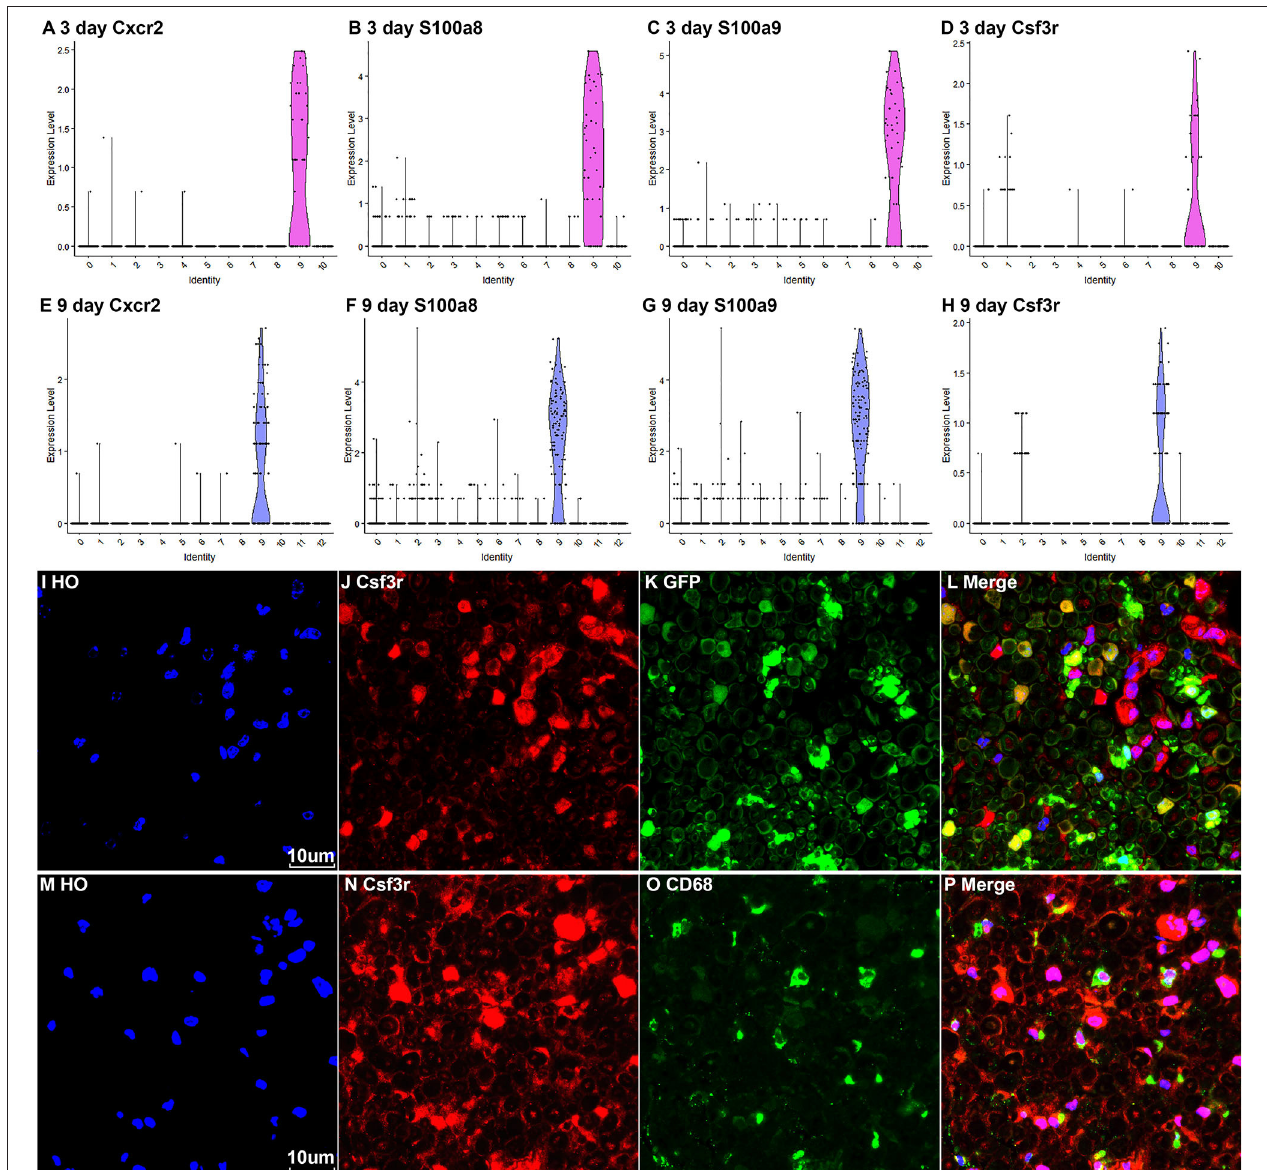
FIGURE 8 | Marker genes for identifying the cluster of neutrophils in injured nerves. (A–D) Violin plot of selected marker genes Cxcr2, S100a8, S100a9, and Csf3r for neutrophils at day 3 post-injury. (E–H) Violin plot of selected marker genes Cxcr2, S100a8, S100a9, and Csf3r for neutrophils at day 9 post-injury. (I–L) Csf3r staining showing neutrophils in the distal nerve of PLP-GFP mice at day 3 post injury. (M–P) Csf3r and Cd68 double staining showing neutrophils in the distal nerve of C57BL/6 mice at day 3 post injury. Scales bars in (I) and (M) 10 µ